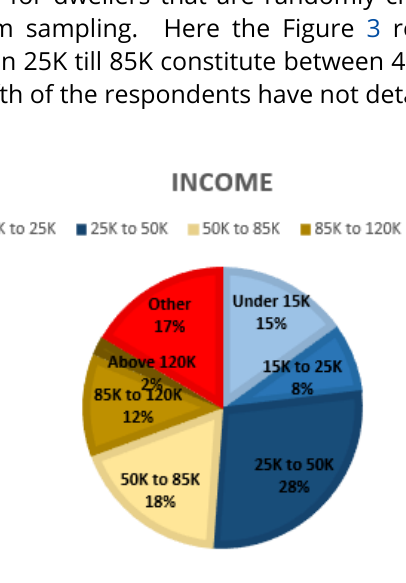
Figure 3: Income distribution of